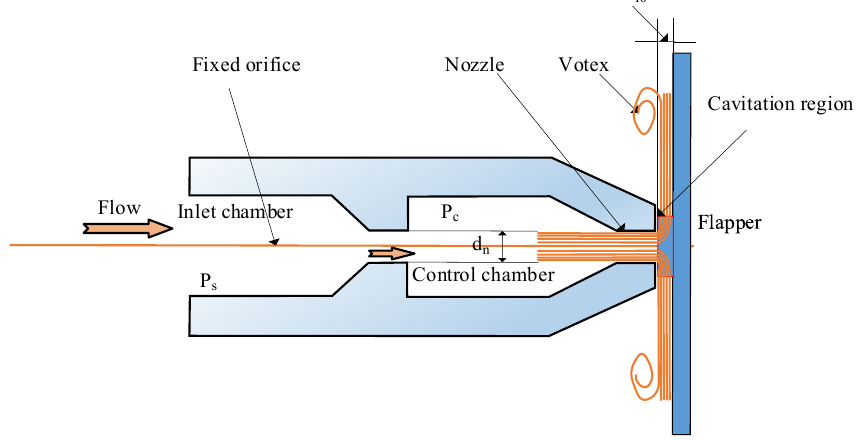
Figure 3. Flow in the pilot stage.